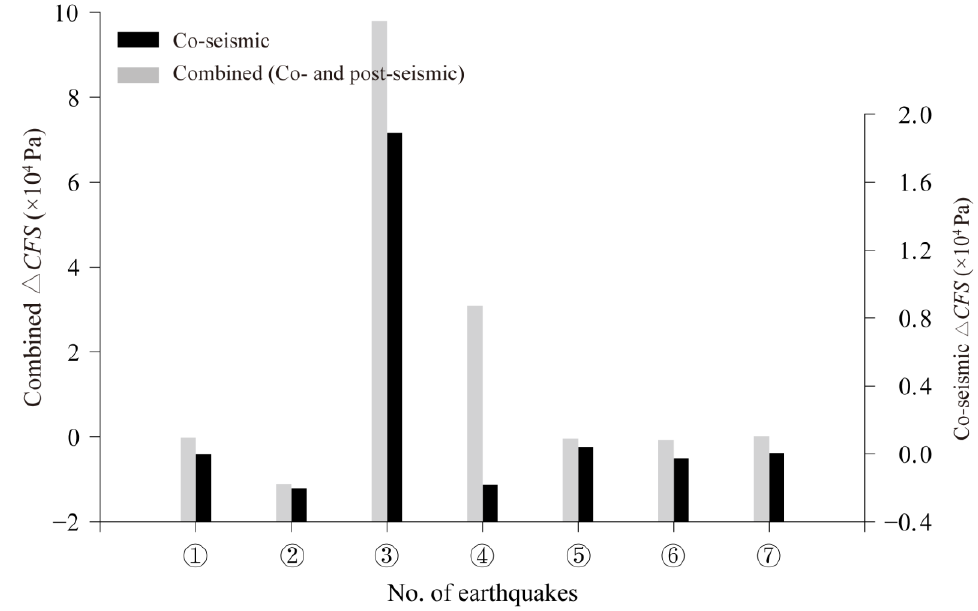
Figure 6. The Co- and combined Coulomb stress change ( Δ CFS ) caused by seven historic earthquakes at the hypocenter of the Nakchu earthquake. Number ① – ⑦ represents the seven events, respectively, same as in Figure 1 and Table 2.